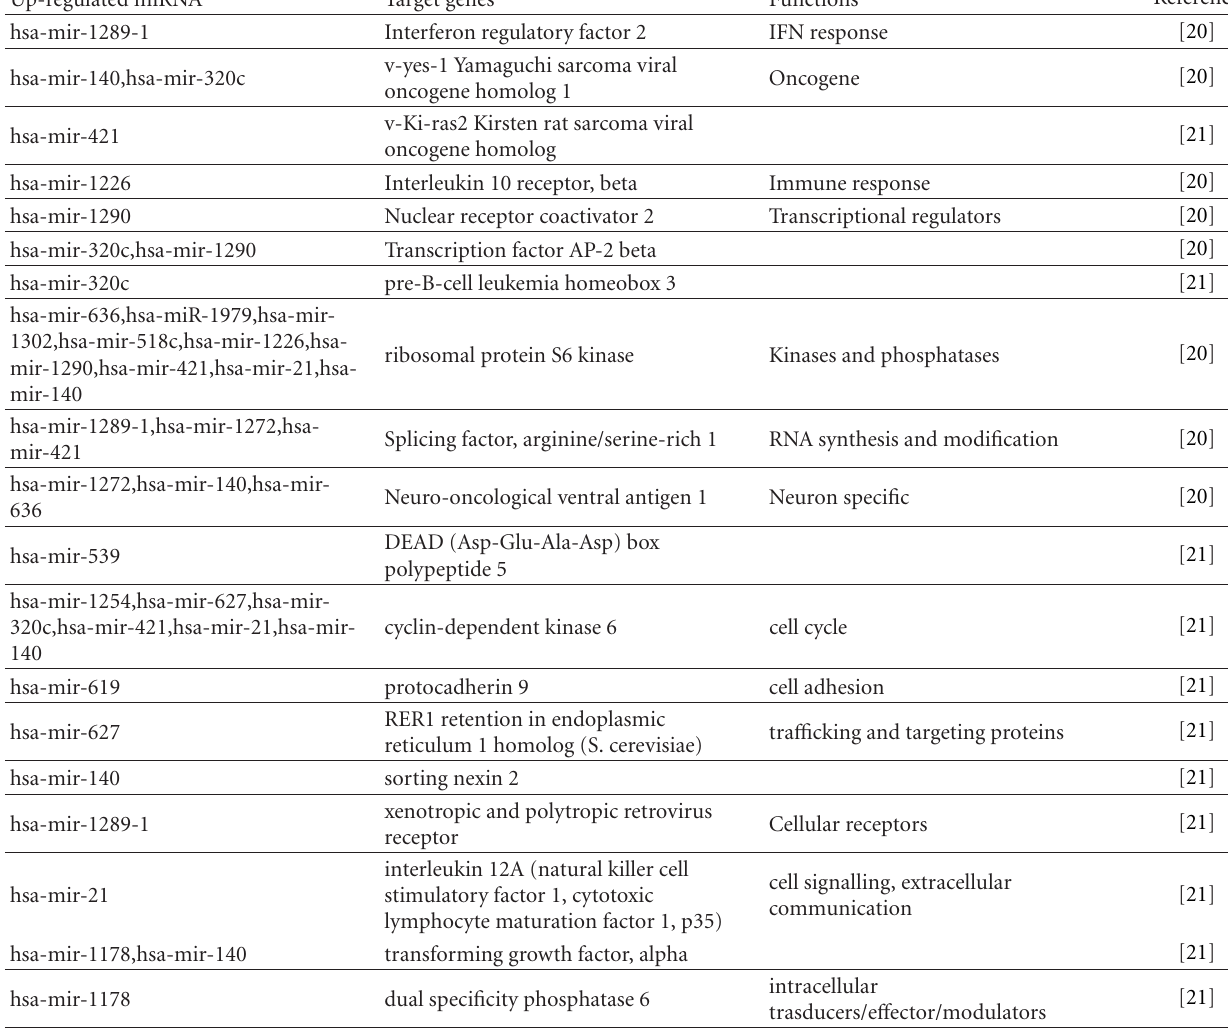
Table 4: Reverse regulatory association of up-regulated miRNAs and their predicted mRNA